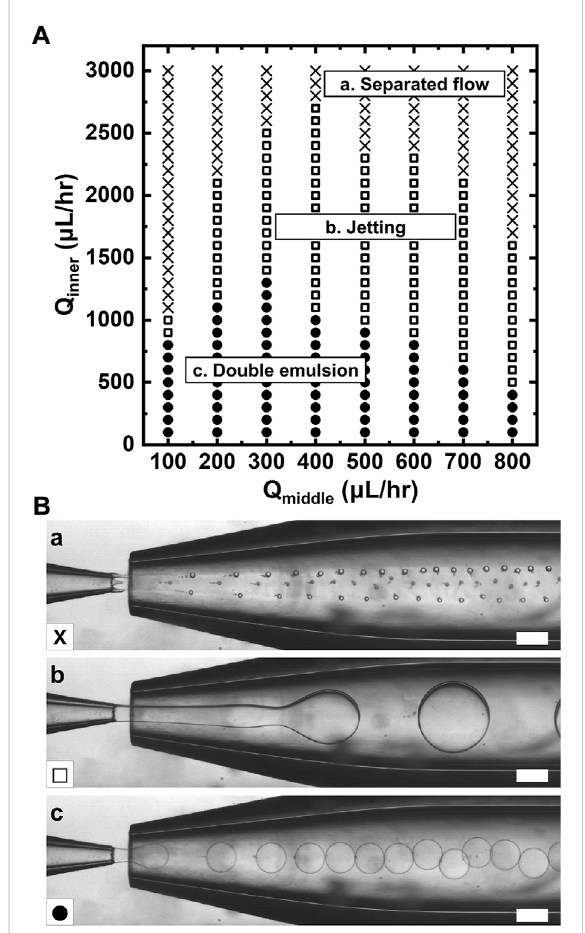
FIGURE 3 Flow patterns formed in the micro fl uidic device. (A) Phase diagram showing fl ow behavior as a function of fl ow rate of the prepolymer solution for inner core (Q inner , y axis) and fl ow rates of the hexadecane for the sacri fi cial oil layer as a middle phase (Q middle , x axis). (B) Bright- fi eld micrographsshowing (a) separated fl ow, (b) jetting, (c) uniform double emulsion, which are denoted as cross, open square, and solid circle, respectively. Scale bars represent 200 μ m.